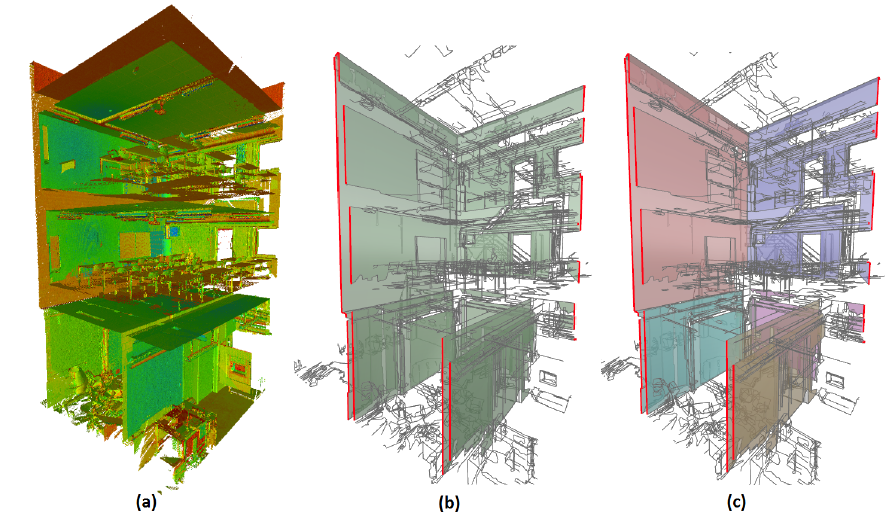
Figure 1. Overview of the different steps in the data association workflow: ( a ) Unstructured point cloud, ( b ) extracted classified planar wall segments, and ( c ) the grouped wall observations per